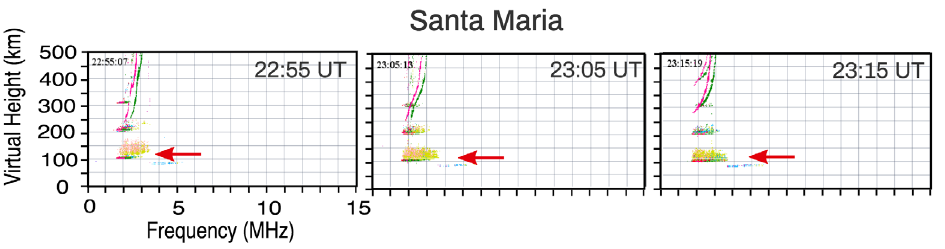
Figure 10. Ionograms collected at Santa Maria on 5 September 2017, showing the atypical Es layer in this station.